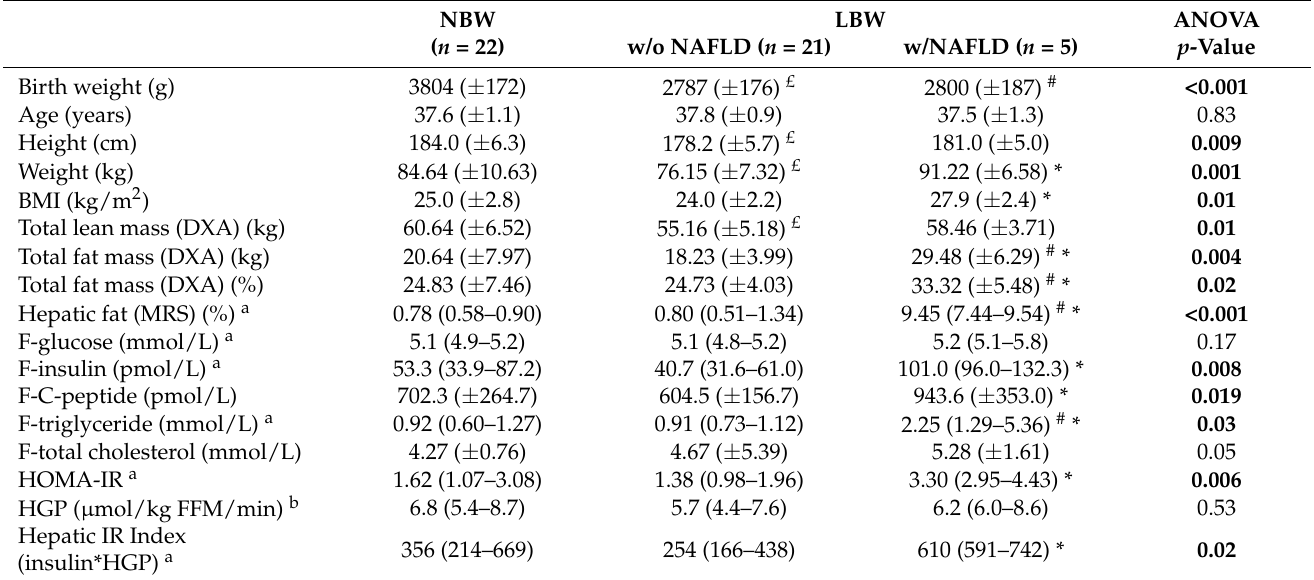
Table 1. Clinical characteristics of the NBW, LBW w/o NAFLD, and LBW w/NAFLD groups.